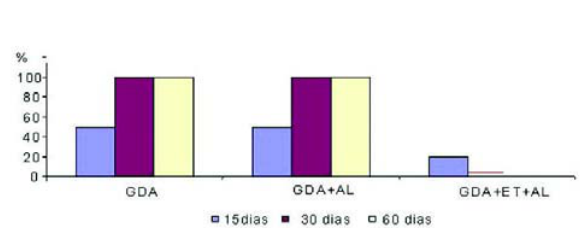
Fig. 2 - Porcentual da presença da reação inflamatória intensa, nos três grupos estudados, ao longo do tempo